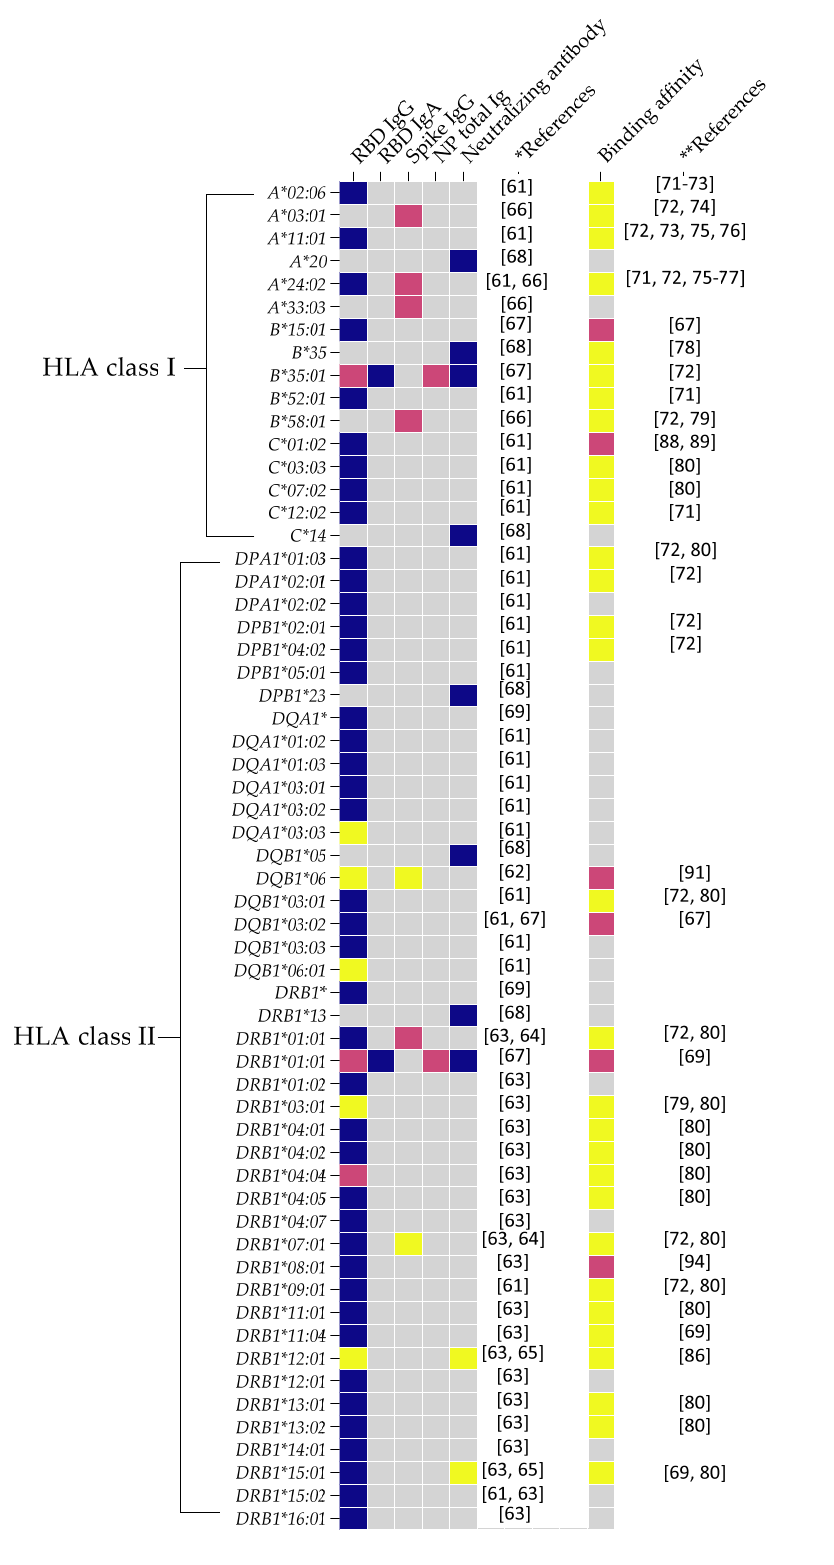
Figure 2. Heat-map showing the association between HLA variants and antibody responses or epitope binding affinity. Associations are depicted arbitrarily as high (scaled 1, yellow boxes), low (scaled 0.5, red boxes), or no association (scaled 0, dark-blue boxes). Gray boxes indicate undetermined values. References shown are for antibody response* or epitope binding affinity** studies.